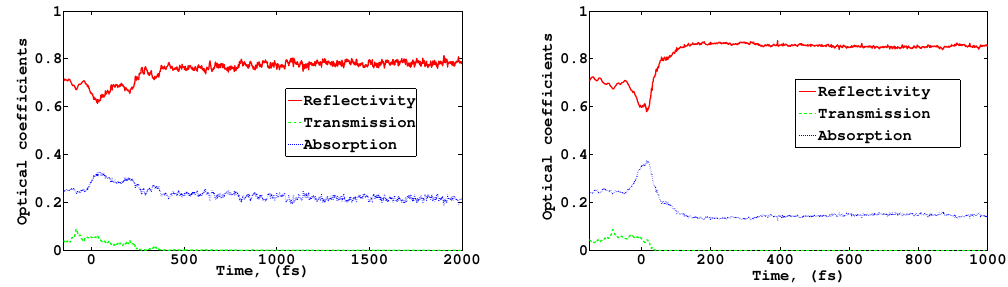
Figure 9. Optical coefficients of silicon irradiated with a dose of 0.66 eV/atom ( left ) and with a dose of 1.78 eV/atom ( right ) calculated with